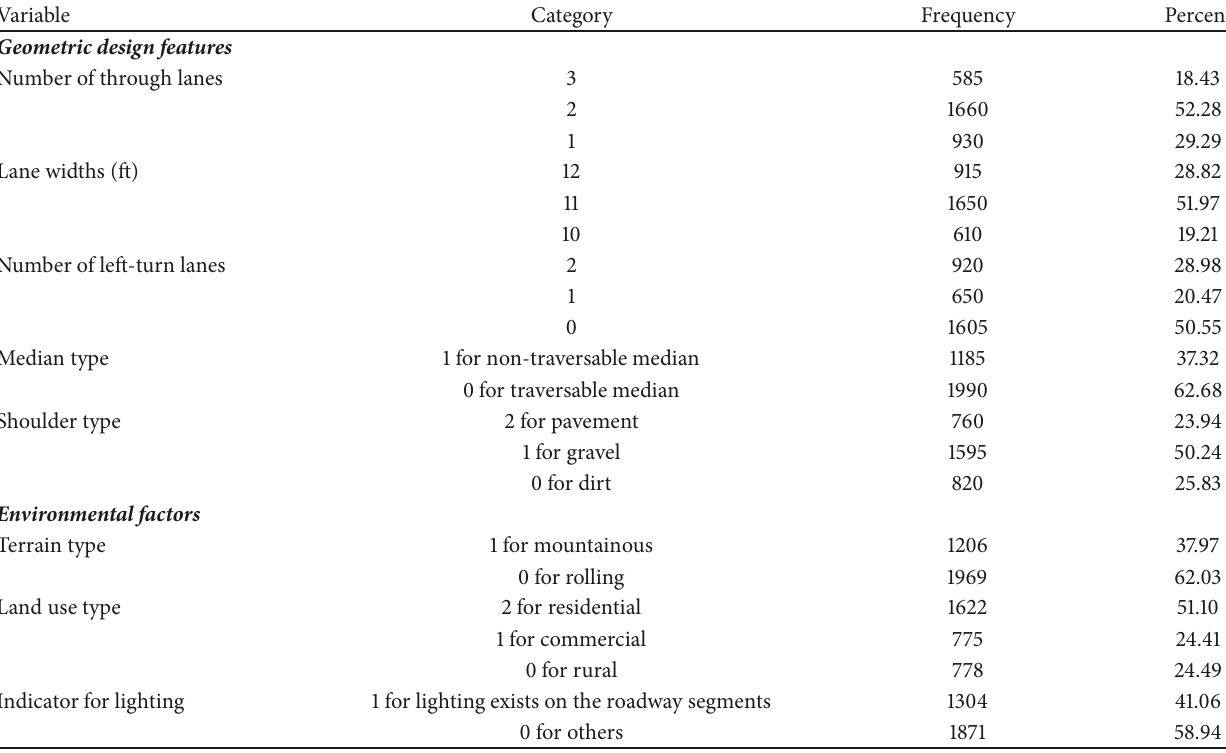
Table 2: Summary statistics of analyzed categorical